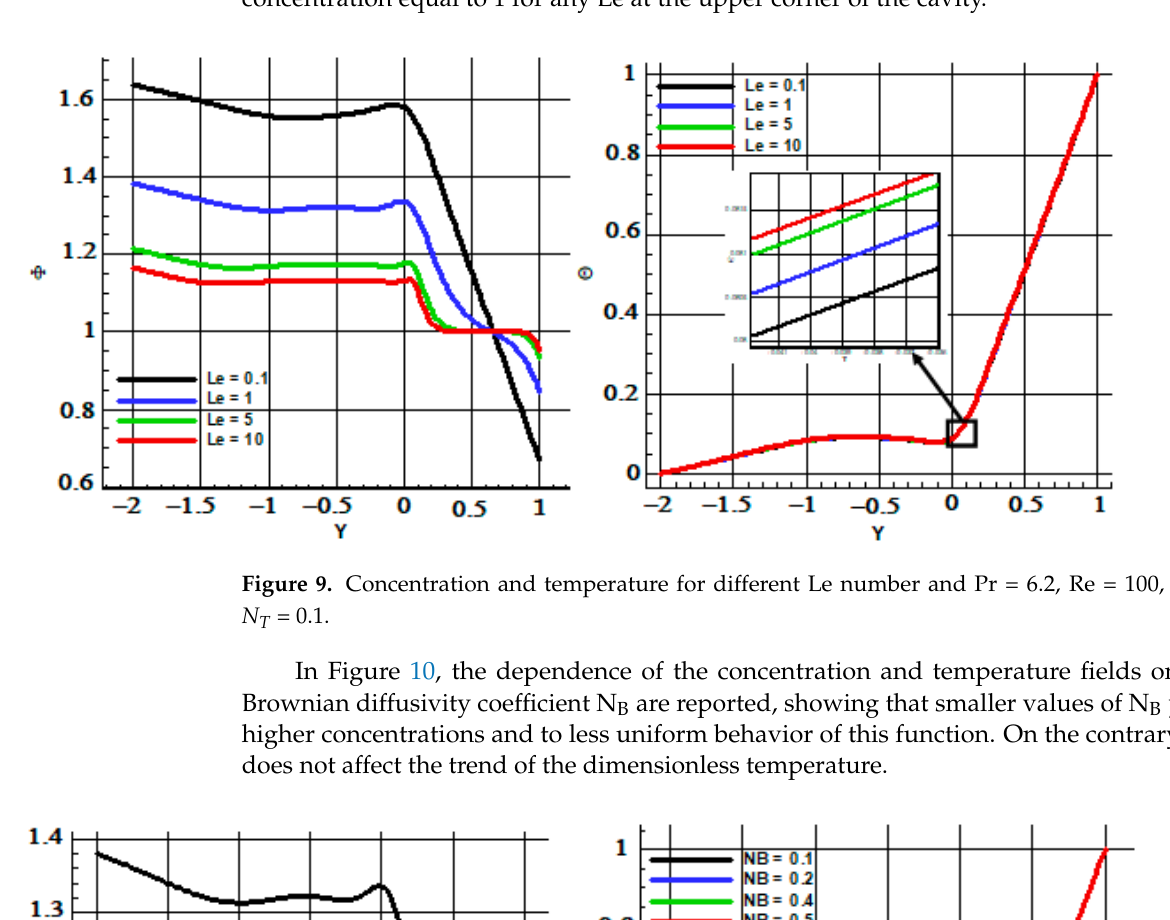
Figure 11. Concentration and temperature for different N T number and Pr = 6.2, Re = 100, Le = 1, N B = 0.1. Finally, in Figures 12 and 13 the averaged Nusselt number on the hot wall is reported versus Re. Figure 12 analyzes the behavior with respect to the Brownian diffusivity coef- ficient (left) and to the thermophoretic diffusivity coefficient (right) and Figure 13 to the Lewis number. Figure 12 shows that the parameter N B does not affect the behavior of the Nusselt number, while N T and Le do, as evident in the right frame of Figure 12 and in Figure 13. In particular, the average Nusselt number is a decreasing function on N T , while it is an increasing function of Le. It is interesting to notice that for high values of N T , that is, N T = 0.5, the function is not monotonic, thus displaying a minimum for Re = 100.